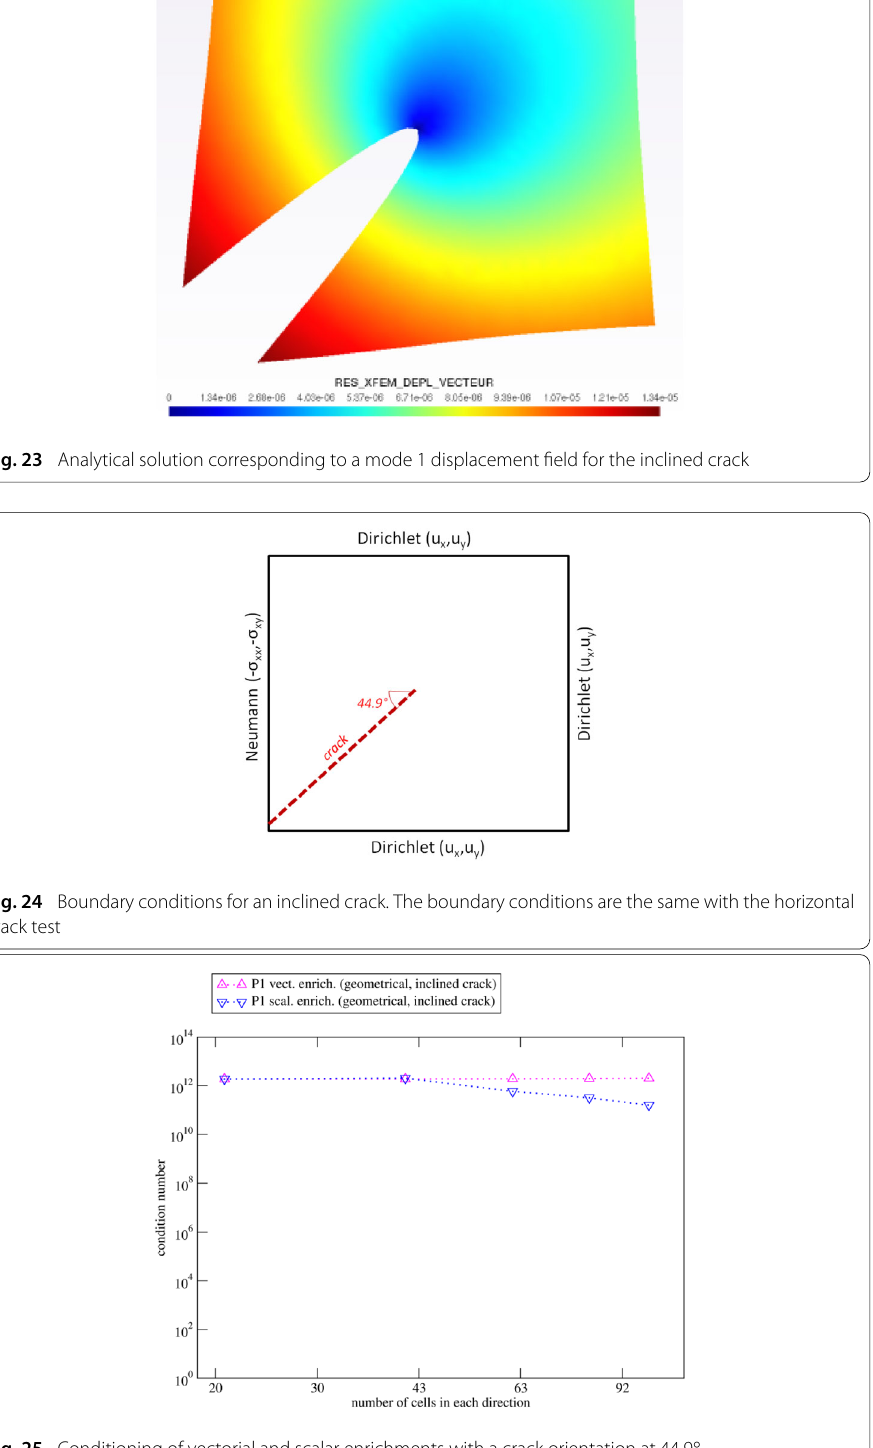
Fig. 25 Conditioning of vectorial and scalar enrichments with a crack orientation at 44 . 9